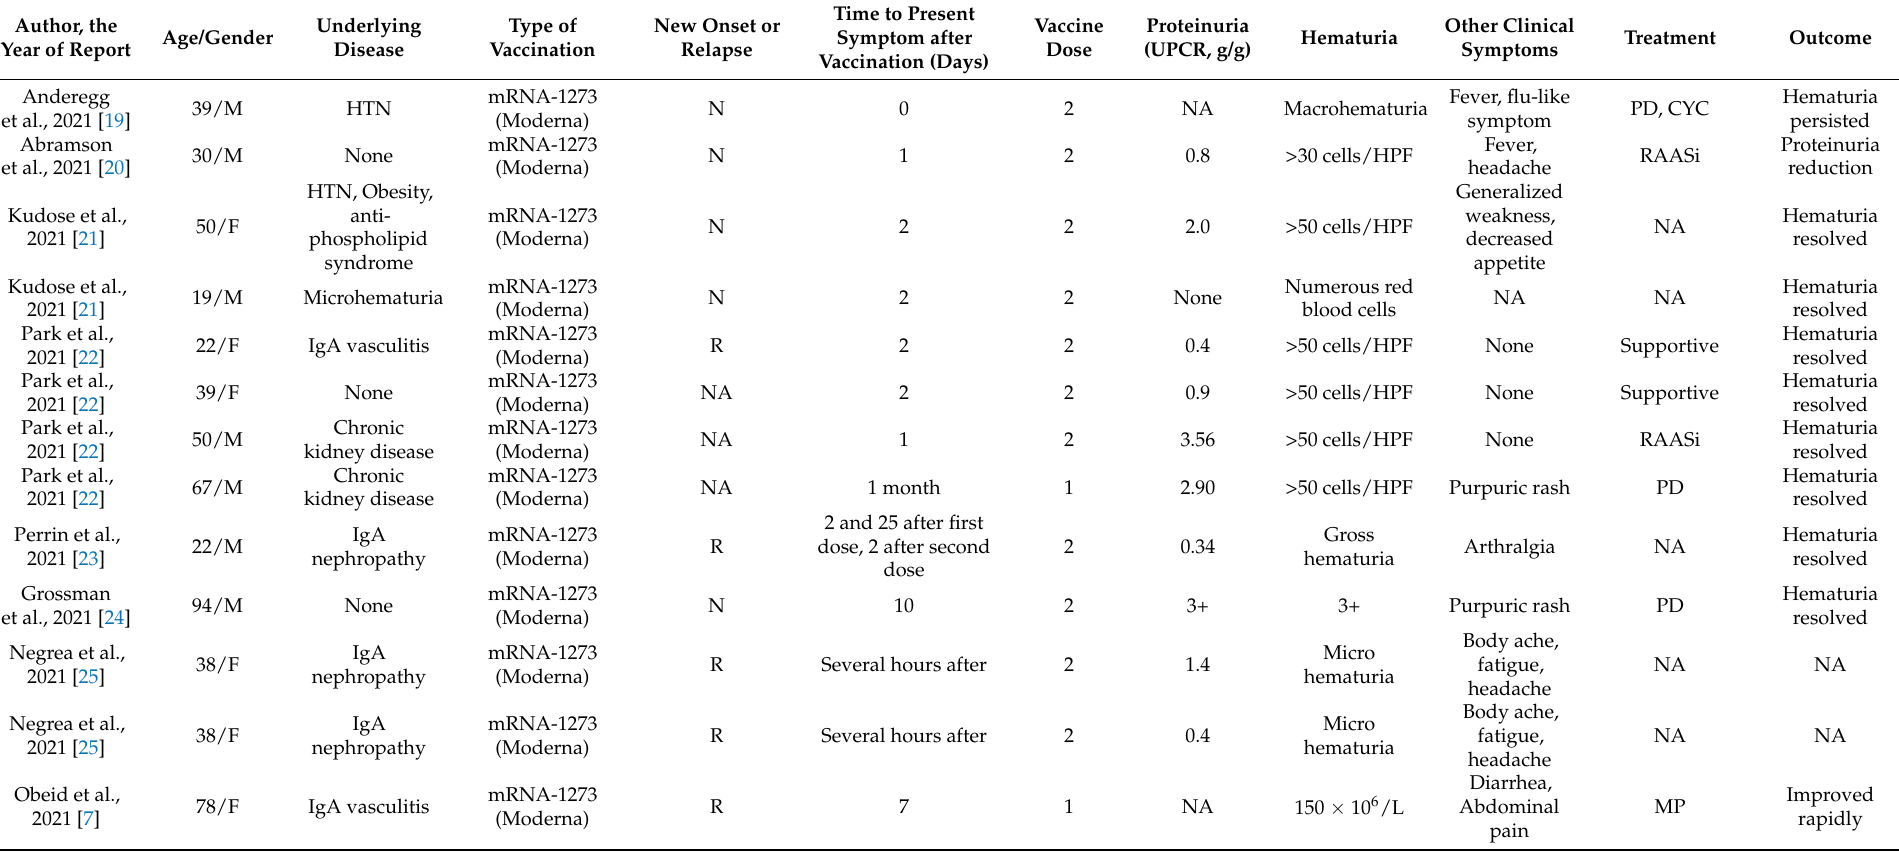
Table 2. A summary of new-onset or relapsed IgA vasculitis following COVID-19